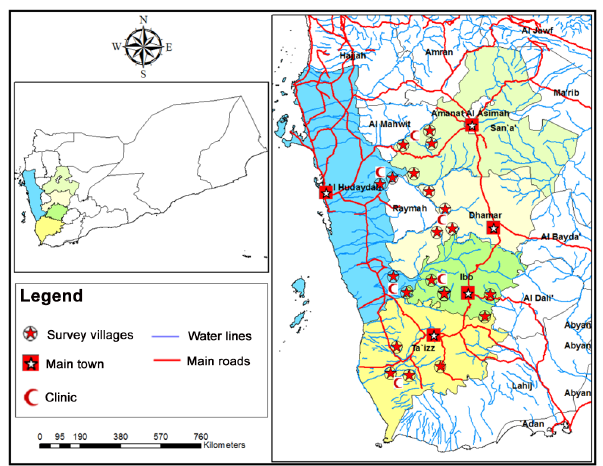
Figure 1. A geographic map showing study area in 5 provinces in